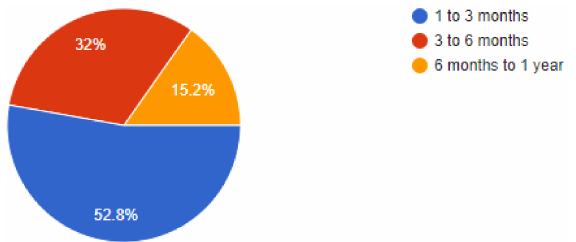
Figure 7. How long do you think patients will be affected by the virus threat?